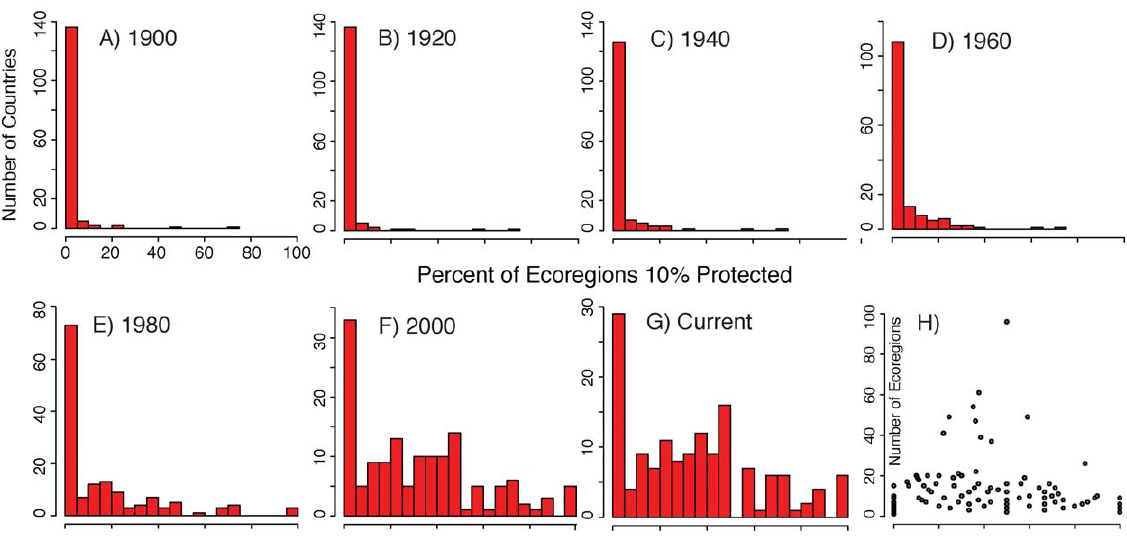
Figure 1. Numbers of countries and the percent of their ecoregions with greater than 10% protection. A , B , C , D , E , F , G each plots the cumulative number of countries at 20 year increments. PAs with no date of creation in the database occur first in 1900, and remain in each preceding temporal increment. H ) Number of ecoregions versus the percent of a country’s ecoregions protected. No trend is found for countries with many ecoregions to differ greatly from those with few.